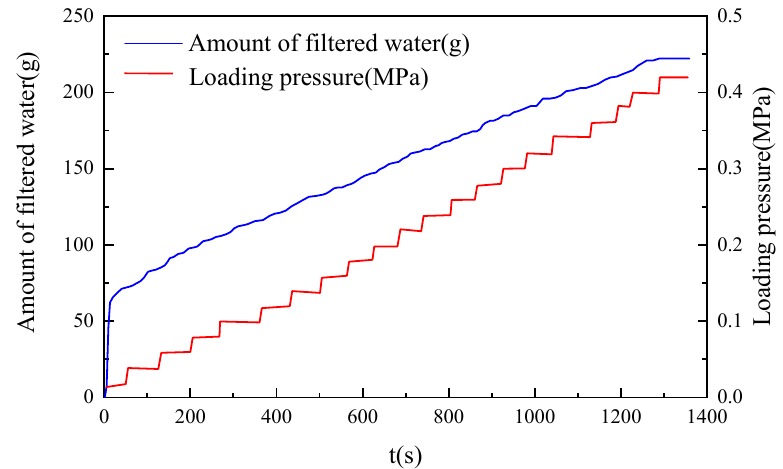
Figure 4. The amount of filtered water varies with loading and time in stratum G1.